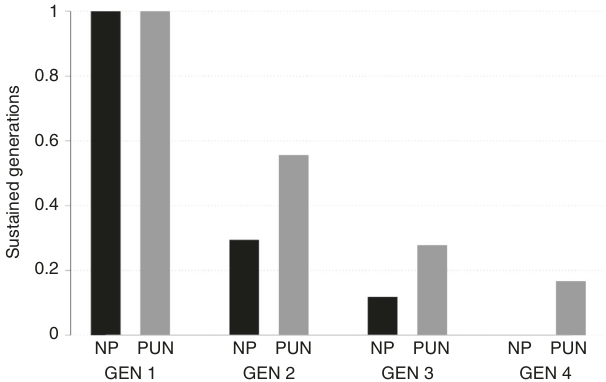
Fig. 2 Sustained generations in the no-punishment (NP: black bars) and punishment (PUN: grey bars) conditions. The availability of a punishment institution more than doubles the average level of sustained generations across all generations. Yet, it does not preserve full cooperation across multiple generations. In the No-punishment condition, 17 groups started in GEN1, and 5, 2, and 0 groups continued to GEN2, GEN3, and GEN4. In the punishment condition 18 groups started in GEN1, and 10, and 5, and 3 groups continued to GEN2, GEN3, and